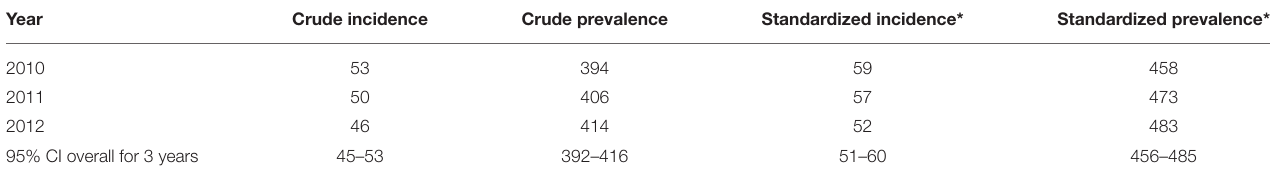
TABLE 3 | Incidence (new patients per 100,000 inhabitants/year) and prevalence (number of patients per 100,000 inhabitants) of PD in Hungary between 2010 and 2012. Year Crude incidence Crude prevalence Standardized incidence* Standardized prevalence*